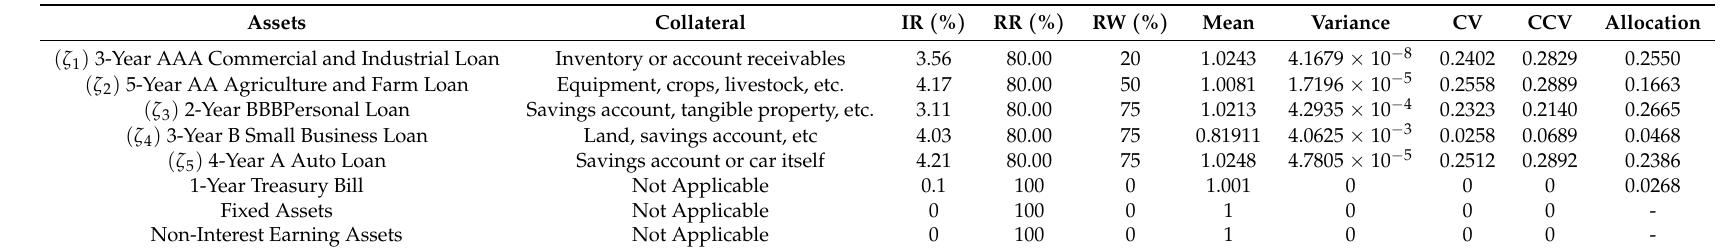
Table 3. Asset structure of a U.S. Bank ( IR, Interest Rate; RR, Recovery Rate; RW, Risk Weights; CV, Credit VaR; CCV, Credit CVaR).